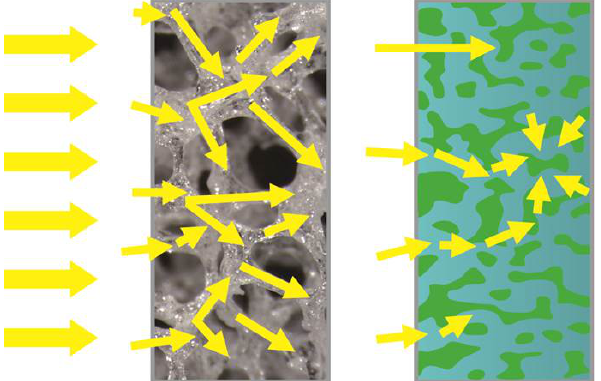
Figure 2. Photograph ( left ) of a transparent sponge with light transmission and the scheme ( right ) of the resulting focus effect due to the illumination of the volume in the pores from all directions. Reprinted/adapted with permission from Ref. [2]. Copyright 2012 Jacobi A, et al.